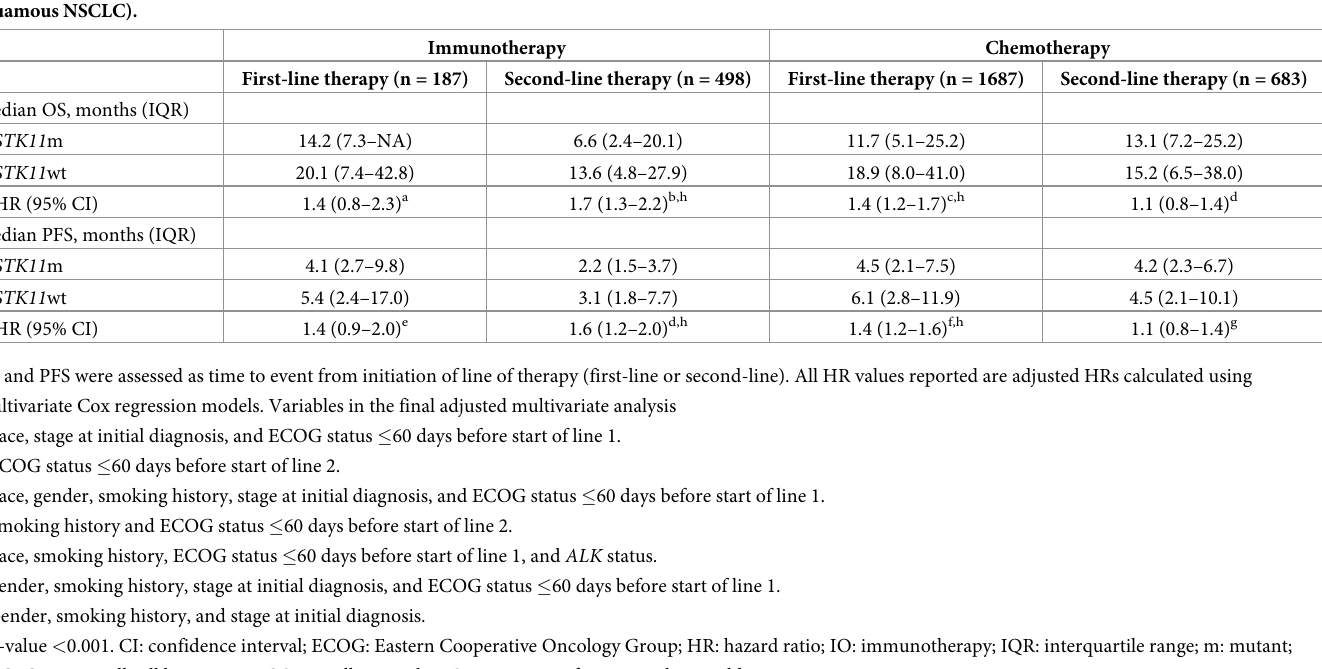
Table 3. Overall survival and progression-free survival from start of first-line and second-line IO and chemotherapy by STK11 mutation status (patients with non- squamous NSCLC).